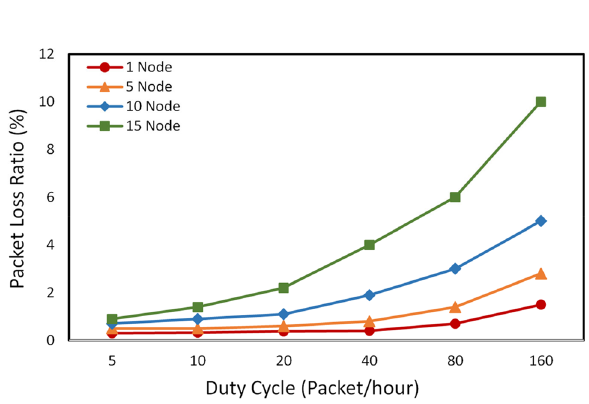
Figure 19. Average packet loss ratio as a function of transmission range.